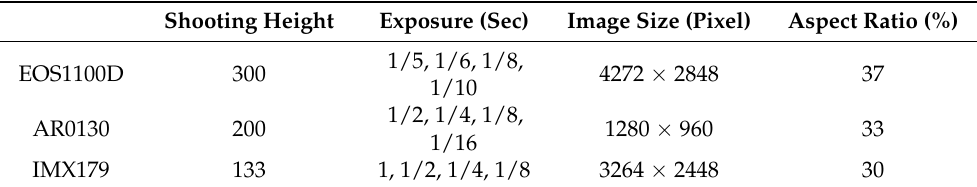
Figure 4. Low-cost gel-document system: ( a ) external appearance; ( b ) internal structure. Table 3. Camera shot conditions.